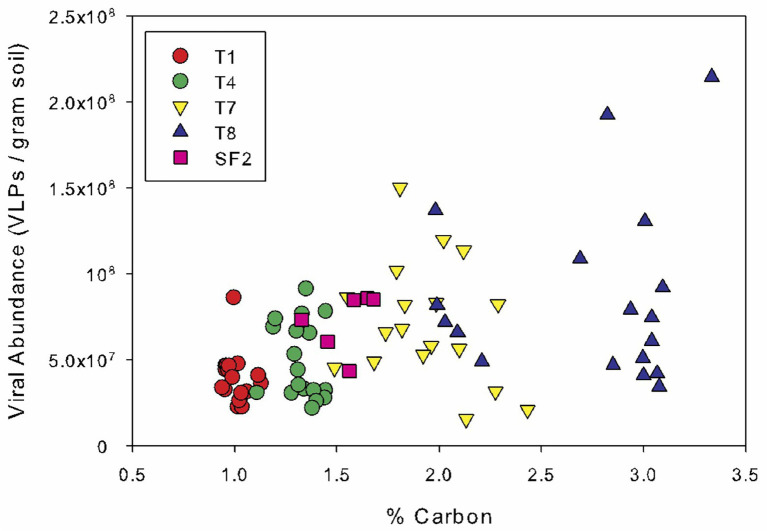
Viral abundance as a function of soil organic carbon. Data points are color-coded by land management type, and all dates are plotted. The land management treatments are the same as described in Figure 1.